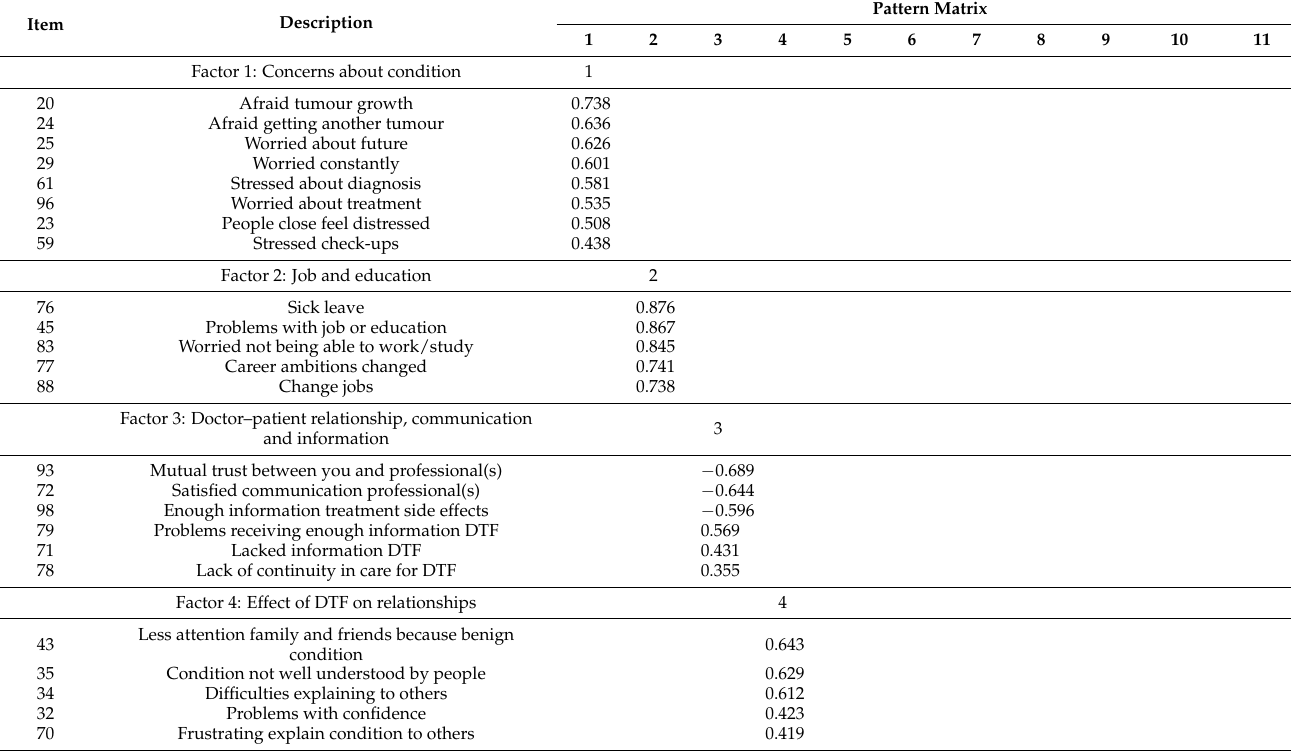
Table 4. Rotated component matrix (factor loadings pattern matrix) items with time frame since